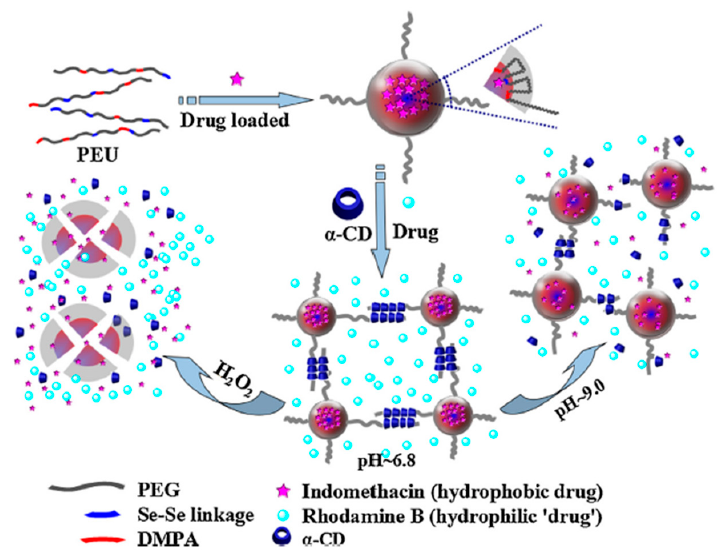
Figure 15. PEU loaded with indomethacin and Rhodamine B. At increasing pH, the nanoparticles swell, resulting in a slipping, loose network; while at increasing H 2 O 2 concentration, the diselenide bonds break, both leading to drug release (Adapted and reprinted with permission from ref. [109] © 2016, Elesevier).